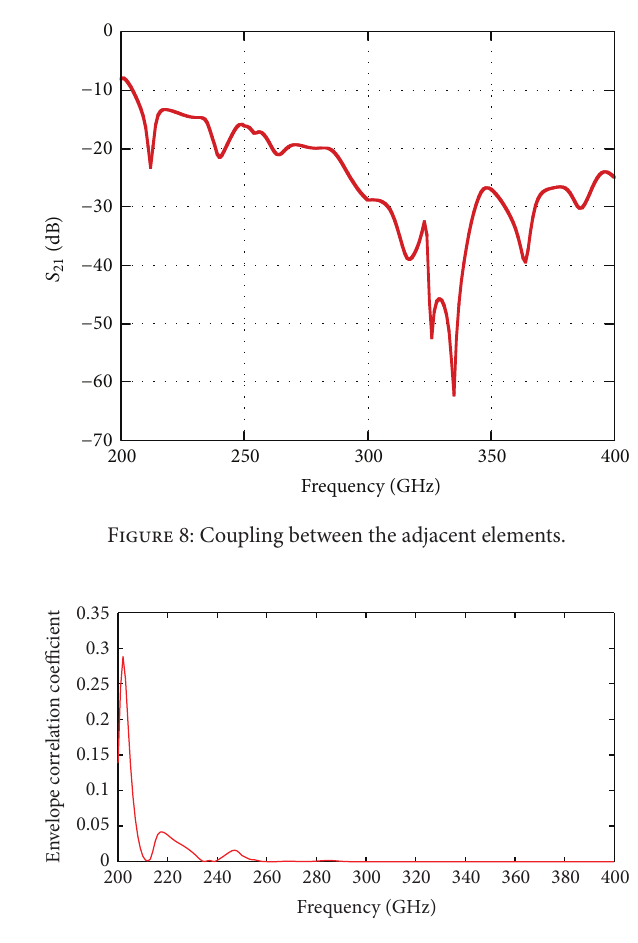
Figure 9: Envelope correlation coefficient.